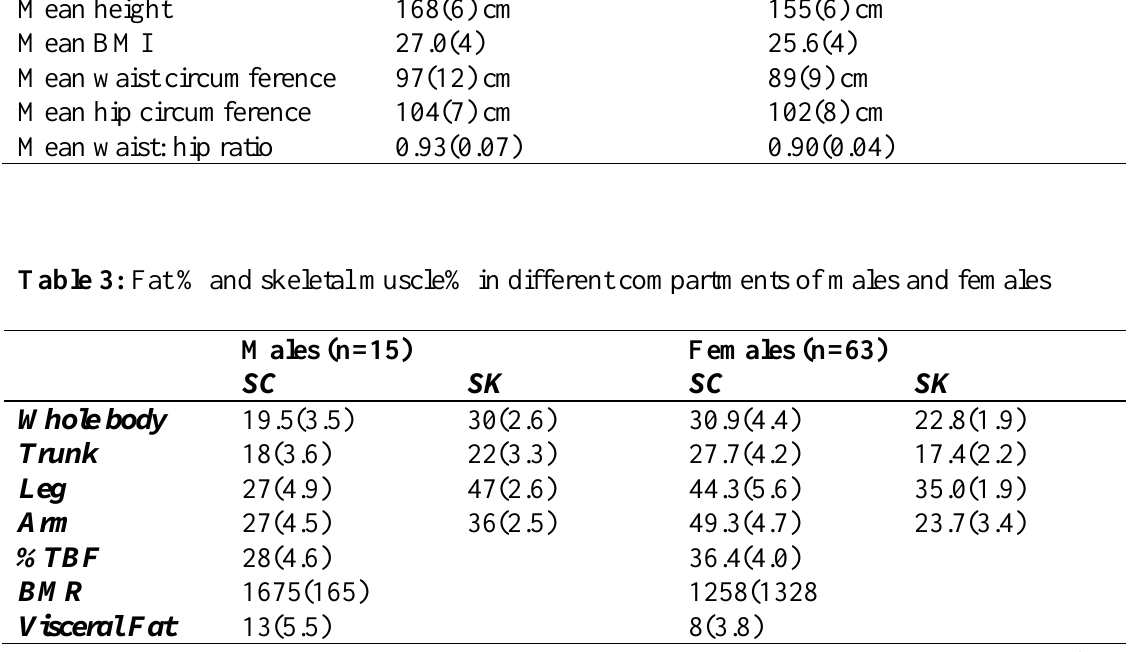
Table 2: Mean weight, height, waist circumference, hip circumference and waist: hip ratios